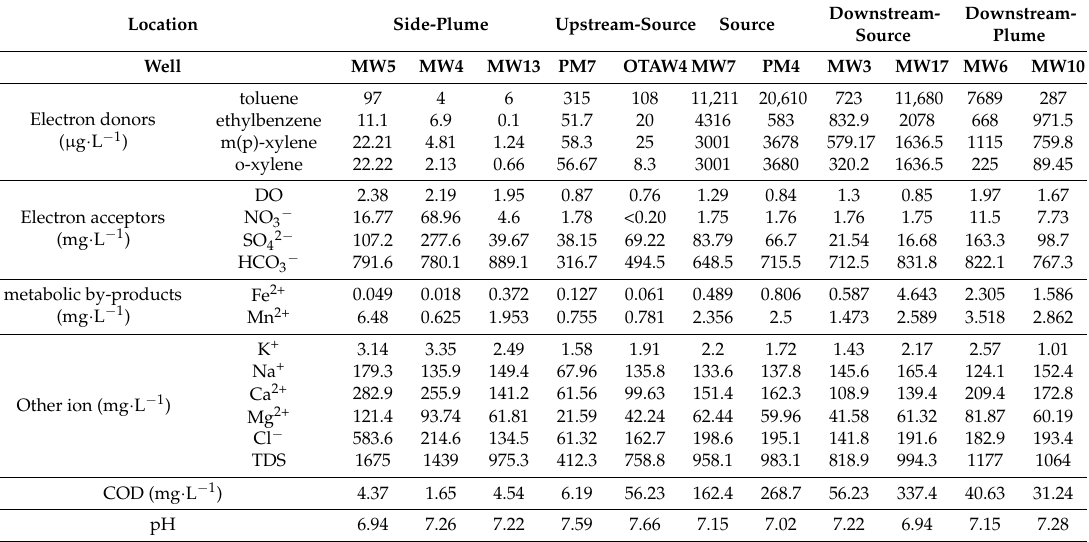
Table 1. Hydrochemical parameters and the contaminant concentrations.